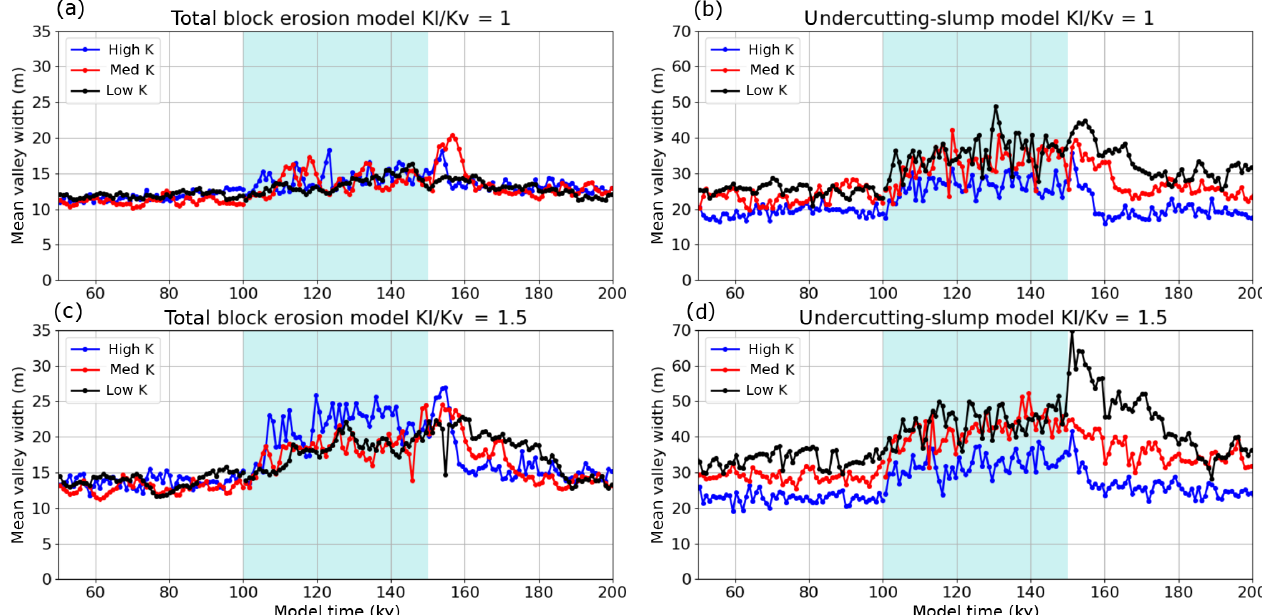
Figure 7. Valley width averaged over the model domain vs. model time for total block erosion and undercutting-slump models with K l /K v = 1 and 1.5. Increased water flux occurs from 100 to 150kyr, indicated by light blue shading.